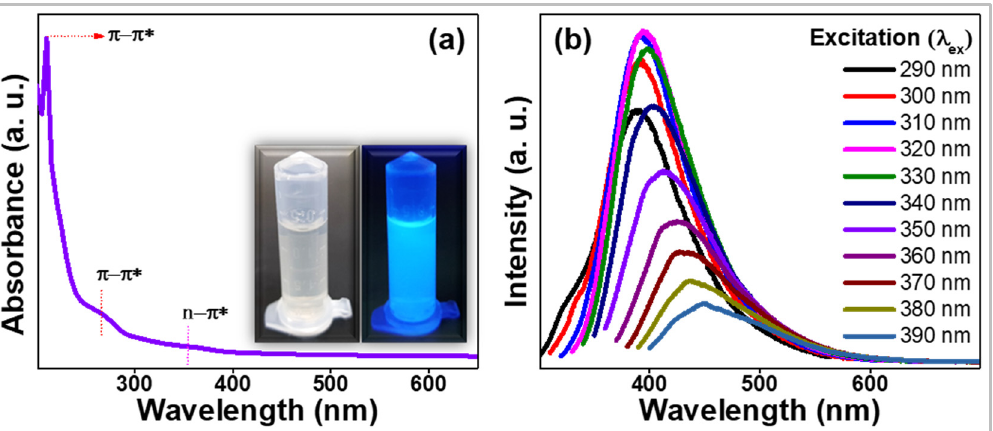
Figure 5. ( a ) UV-vis absorption spectrum and ( b ) fluorescence emission spectrum upon varying the excitation of prepared natural nitrogen-doped carbon dots. Inset ( a ): digital photographs of aqueous solution of natural nitrogen-doped carbon dots under daylight (left) and 365 nm UV light (right).